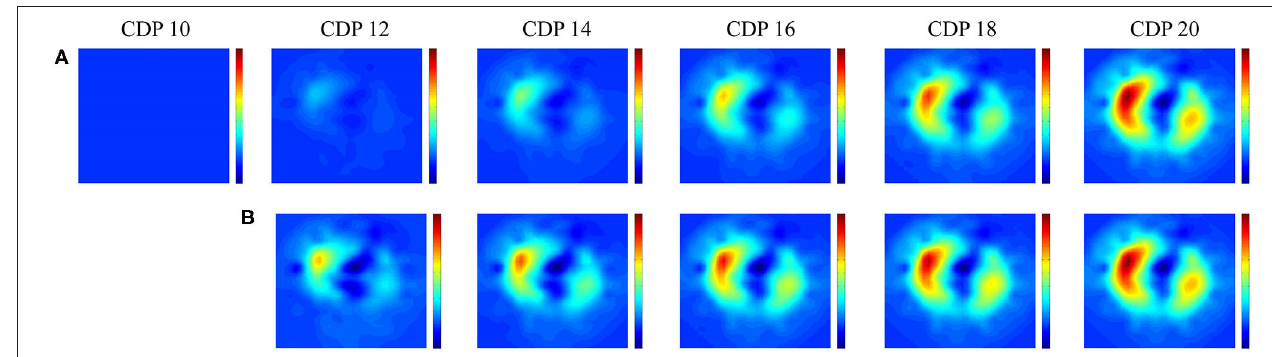
FIGURE 1 | Lung recruitment visualized by Electric Impedance Tomography. Change in functional electrical impedance tomography in end expiratory lung impedance during an oxygenation guided lung recruitment procedure in a high frequency ventilated pre-term infant (945 grams). The impedance changes are referenced to the starting pressure of 8cm H 2 O. Row (A) shows the inflation and row (B) the deflation limb of the recruitment procedure (39). All images have the same scale where red indicates a large change and blue a small change in impedance.